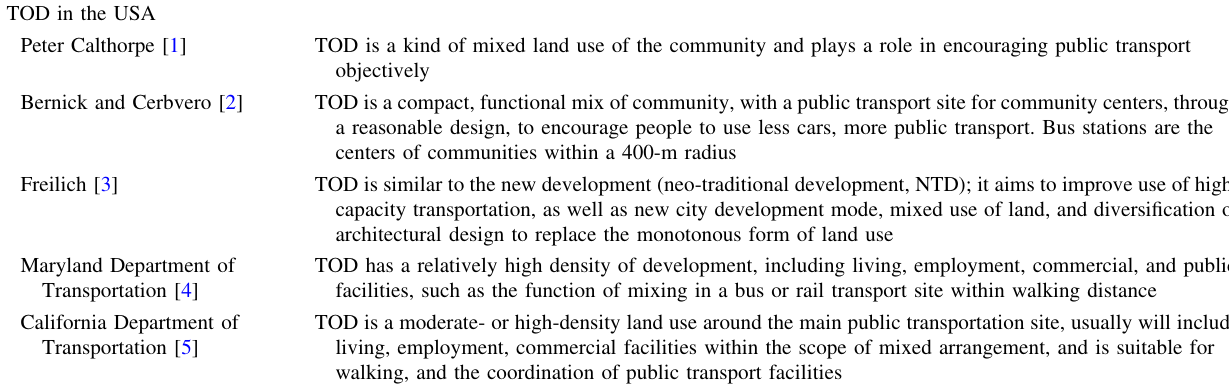
Table 1 Literature on TOD in the USA TOD in the